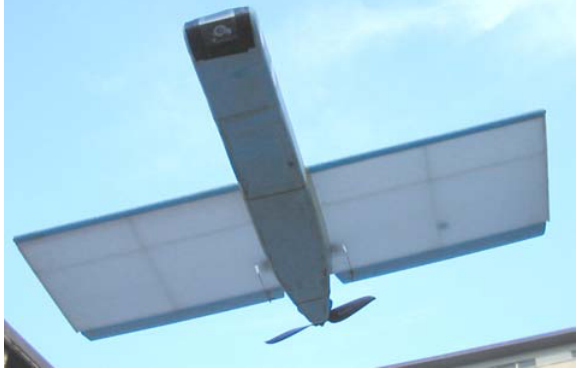
Fig 4. Mini-UAV in flight